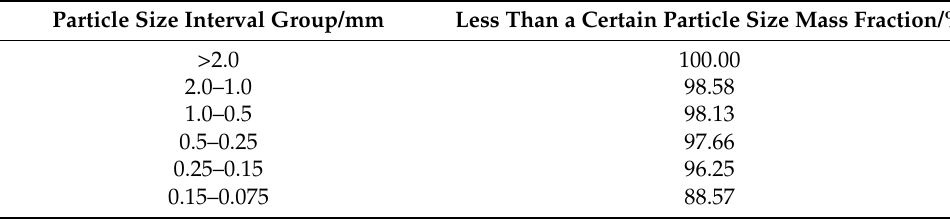
Table 1. Particle size table of soil samples.